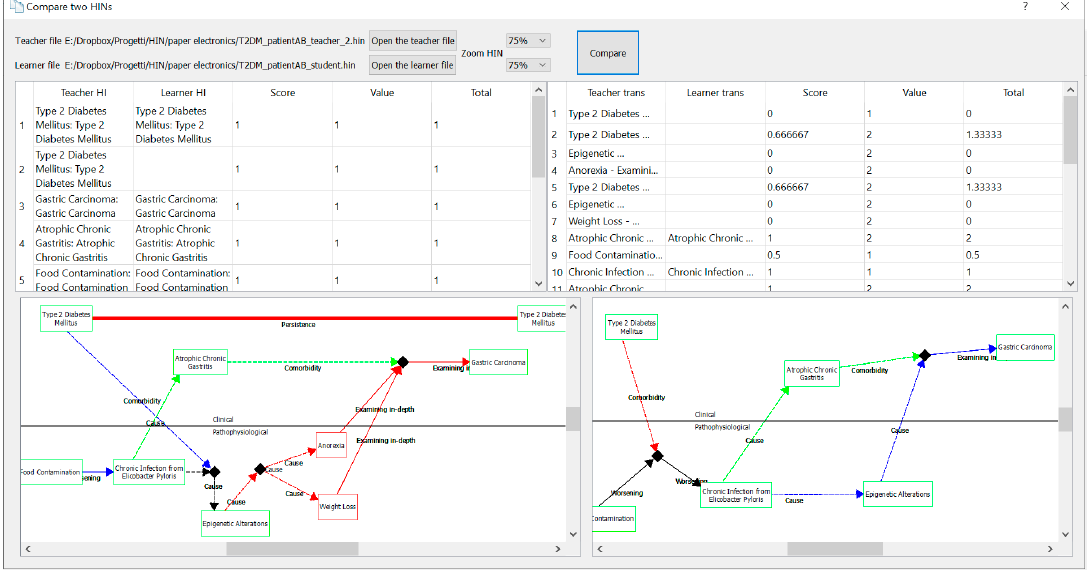
Figure 5. Screenshot of the application comparator